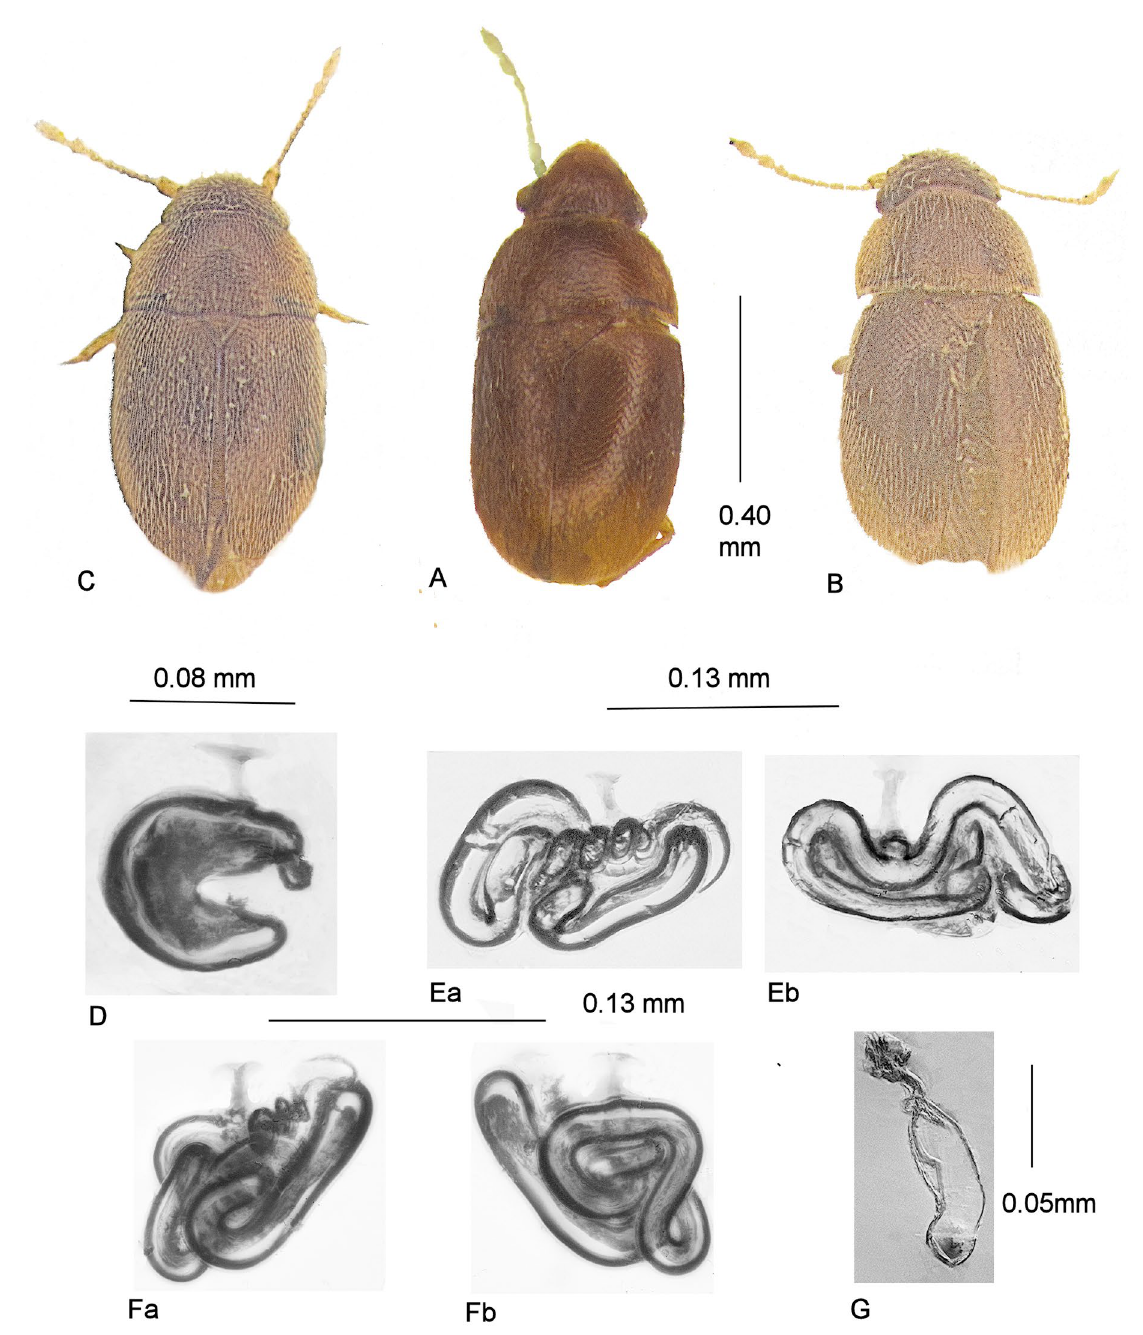
Fig. 3. A–C . Bambara spp., habitus. A . B. hammondi sp. nov. B . B. tortuosa sp. nov. C . B. subtortuosa sp. nov. D–F . Bambara spp., spermathecae. D . B. hammondi sp. nov. Ea–Eb . B. tortuosa sp. nov. Fa– Fb . B. subtortuosa sp. nov. G . Bambara tortuosa sp. nov.,